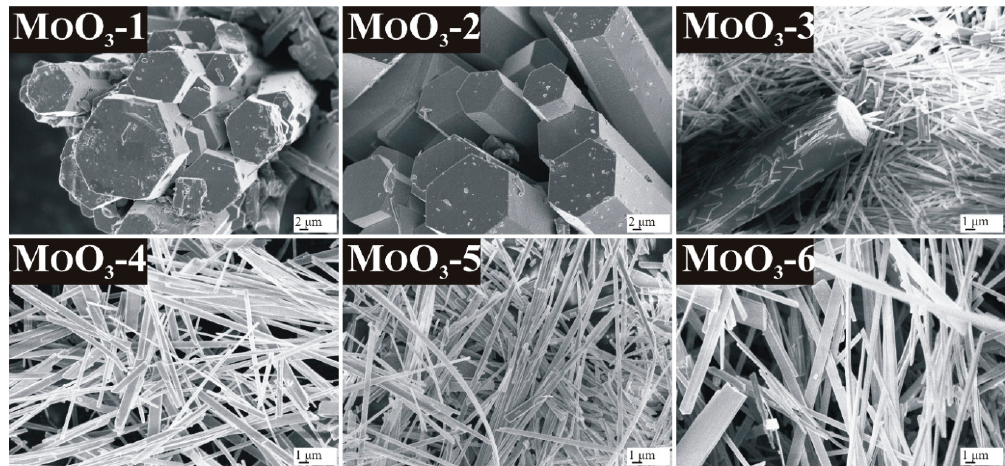
Figure 2. SEM images of the samples synthetized in the hydrothermal reaction of AHM and HNO 3 at different temperatures and durations, MoO 3 -1 90 °C, 3 h, MoO 3 -2: 90 °C, 6 h, MoO 3 -3: 210 °C, 3 h, MoO 3 -4: 210 °C, 6 h, MoO 3 -5: 240 °C, 3 h, MoO 3 -6: 240 °C, 6 h.